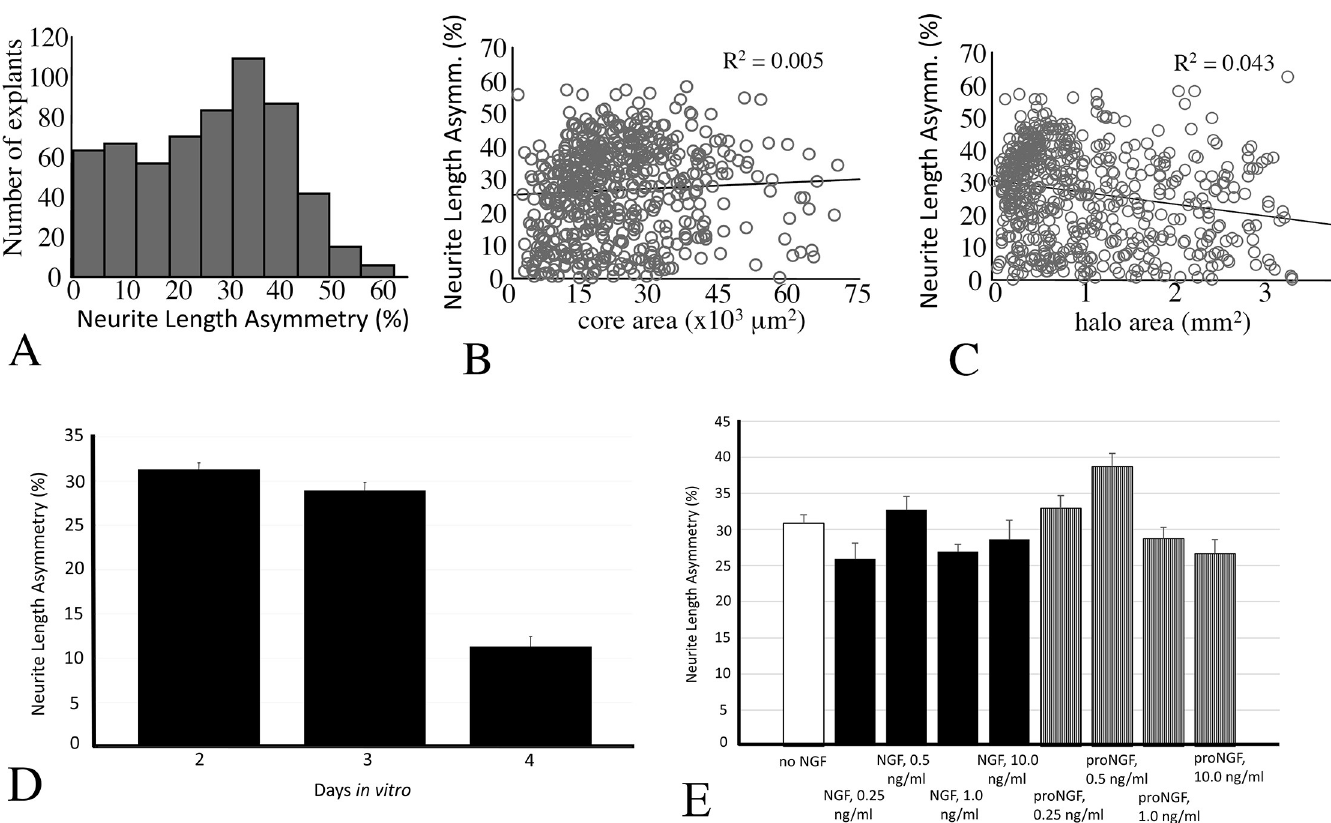
Fig 4. Prevalence and extent of neurite length asymmetry. [A] Histogram showing the prevalence of neurite length asymmetry in 603 explants cultured in Neurobasal medium for 2–4 days and stained with vital dye. The majority showed asymmetry of at least 15%. Bivariate scattergrams showing the distribution of asymmetry as a function of explant core [B] and halo [C] areas. The extent of neurite length asymmetry showed no direct correlation with either variable. Neurite length asymmetry diminished by day 4 [D]. Neurite length asymmetry was present without treatment with NGF, and treatment with NGF or proNGF at various concentrations [E]. Greatest neurite length asymmetry was observed with 0.5 ng/ml NGF or proNGF. Bars in [D] and [E] represent mean ±